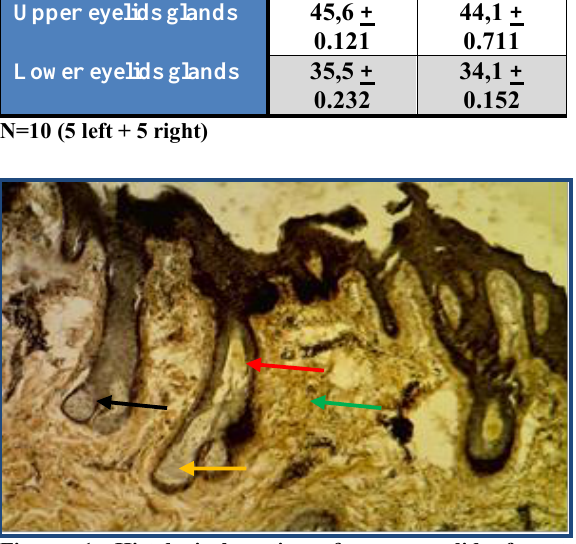
Figure, 1: Histological section of upper eyelid of goat